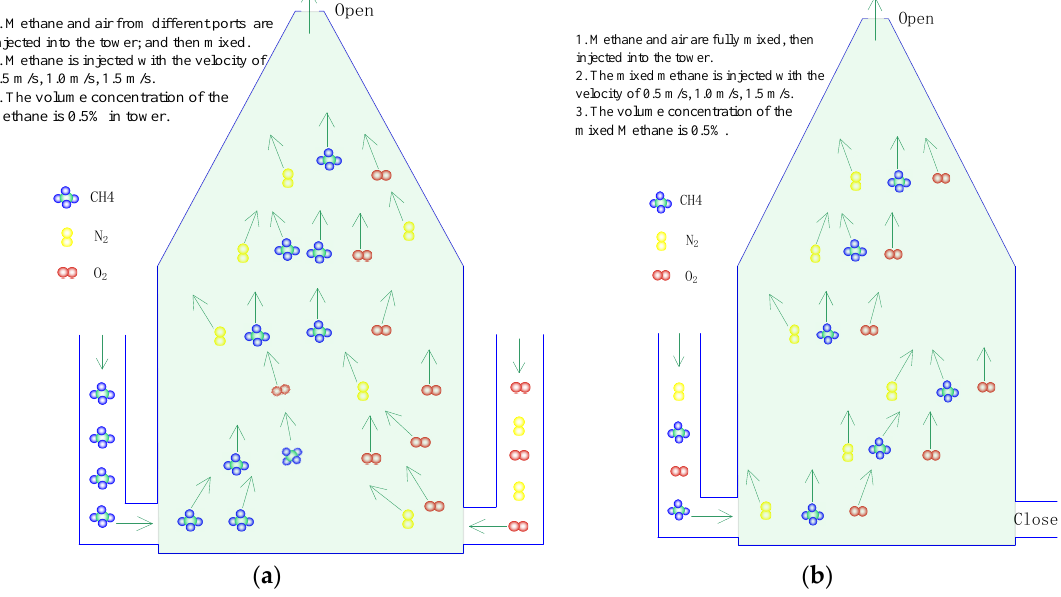
Figure 2. Diagram of the methane enrichment experiment in free diffusion conditions. ( a ) The segregation methane experiment; ( b ) The non-segregation methane experiment.